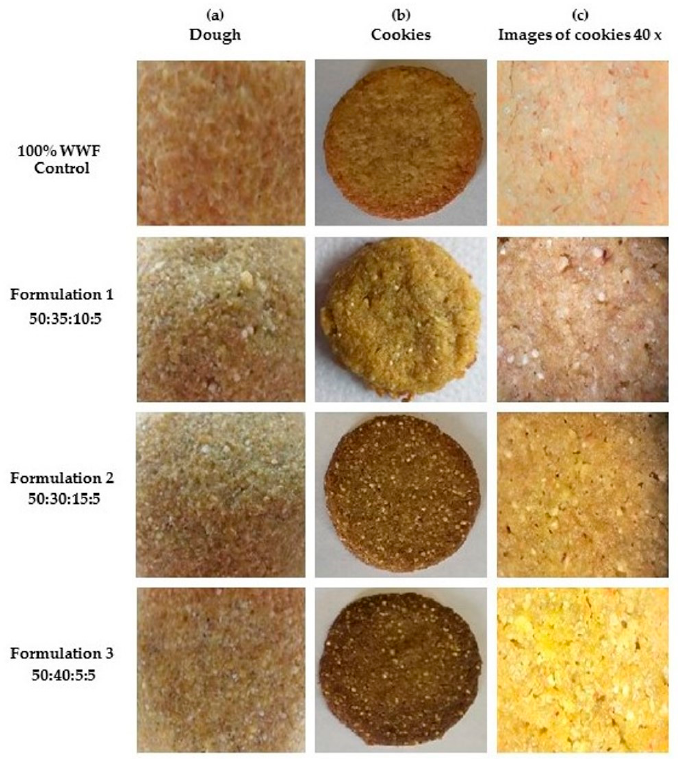
Figure 2. Representative photographs of doughs ( a ), obtained cookies ( b ), and the microscopical appearance of cookies at 40× magnification ( c ) for control and enriched cookies. The proportion of flours’ ingredients is indicated for each formulation as whole wheat:amaranth:nopal: Pleurotus ostreatus flours